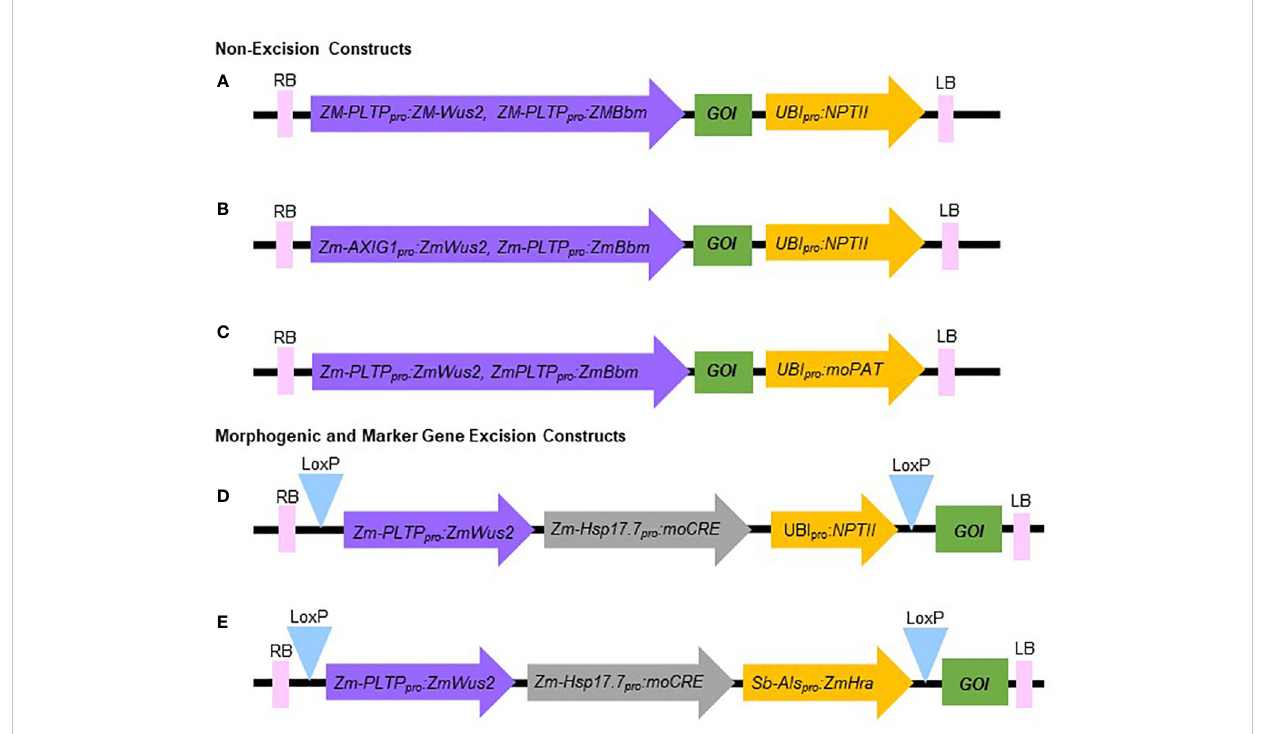
FIGURE 3 Schematic representation of the molecular components of constructs used in this study. (A, B) Non-excision constructs using NPTII as selectable marker. (C) Non-excision construct using moPAT as selectable marker. (D) Morphogenic and marker gene excision construct using NPTII as selectable marker. (E) Morphogenic and marker gene excision construct using Hra as selectable marker. RB, Right border; LB, Left border; GOI, Gene of